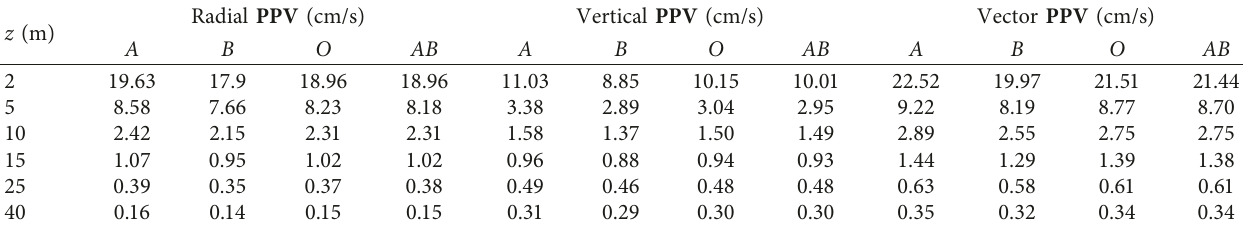
Table 1: Computational PPV s observed along the axial direction of the cylindrical charge.